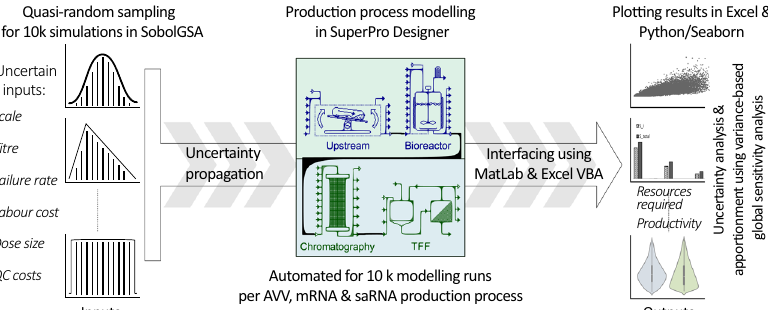
Fig. 1 Computational framework for uncertainty quanti fi cation in vaccine production platforms. The aim of this approach is to evaluate process performance under uncertainty and variability resulting from both the design and operation of the new vaccine production platform technologies. The uncertainty is propagated from input factors to key performance indicators (KPIs) via the mathematical model. Then, the KPI variation ranges are apportioned back to each input factor as sensitivity indices. Input factors include scale of production process, batch failure rate, titre/yield in the production bioreactor, cost of labour, drug substance amount per dose, and cost of quality control. KPIs include capital investment cost requirements, operating costs, number of batches produced per year, amount of drug substance produced per batch, amount of drug substance produced per year, number of doses produced per batch, number of doses produced per year, and production cost per